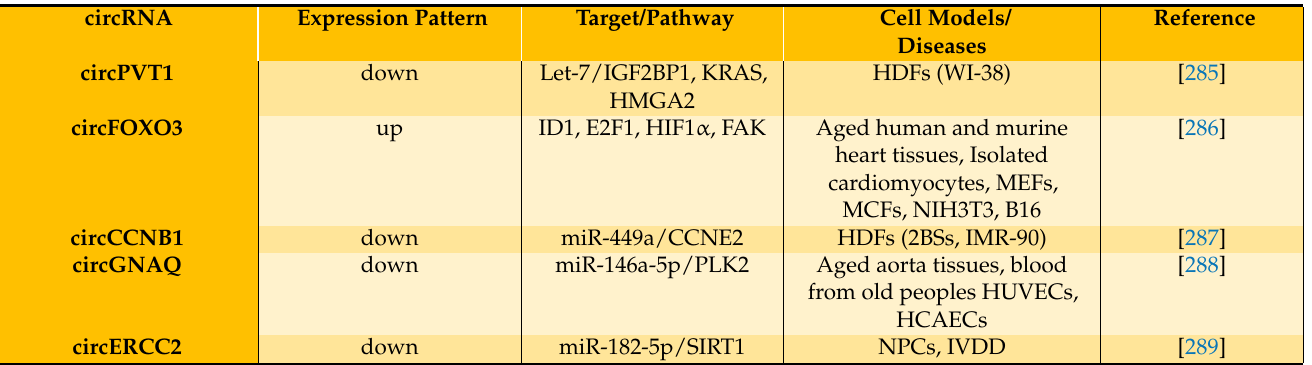
Table 3. List of circRNAs whose expression and targets/pathways are implicated in oxidative stress-induced